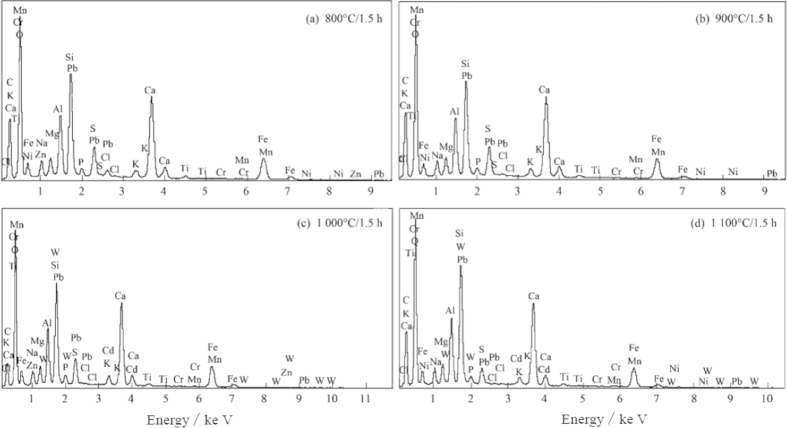
EDS photographs of fly ash after incineration at (a) 800 °C (b) 900 °C (c) 1000 °C (d) 1100 °C for 1.5 hour.